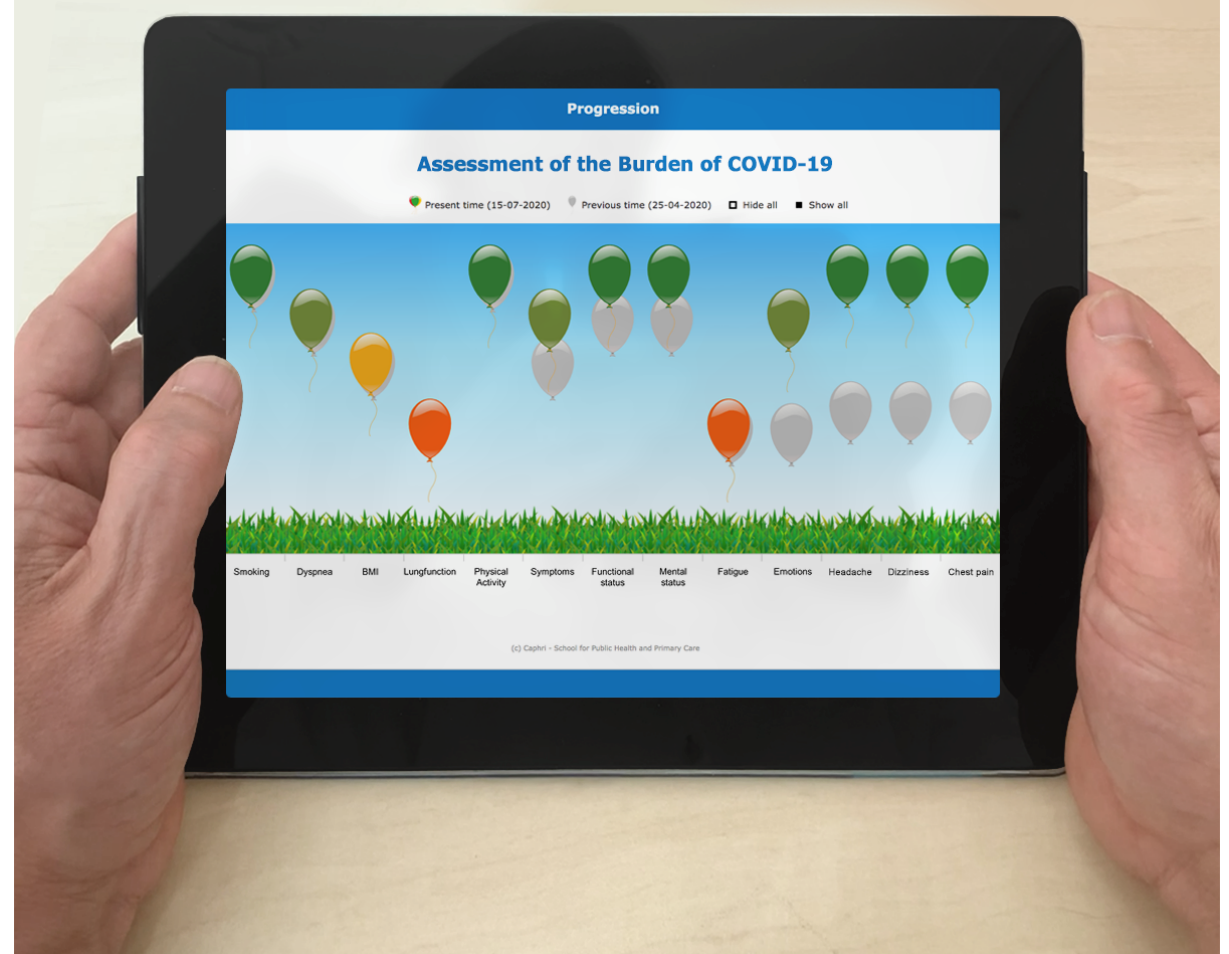
Figure 2. Visualization of the ABCoV tool. ABCoV: assessment of burden of COVID-19; FEV1: forced expiratory volume in the first second of expiration.